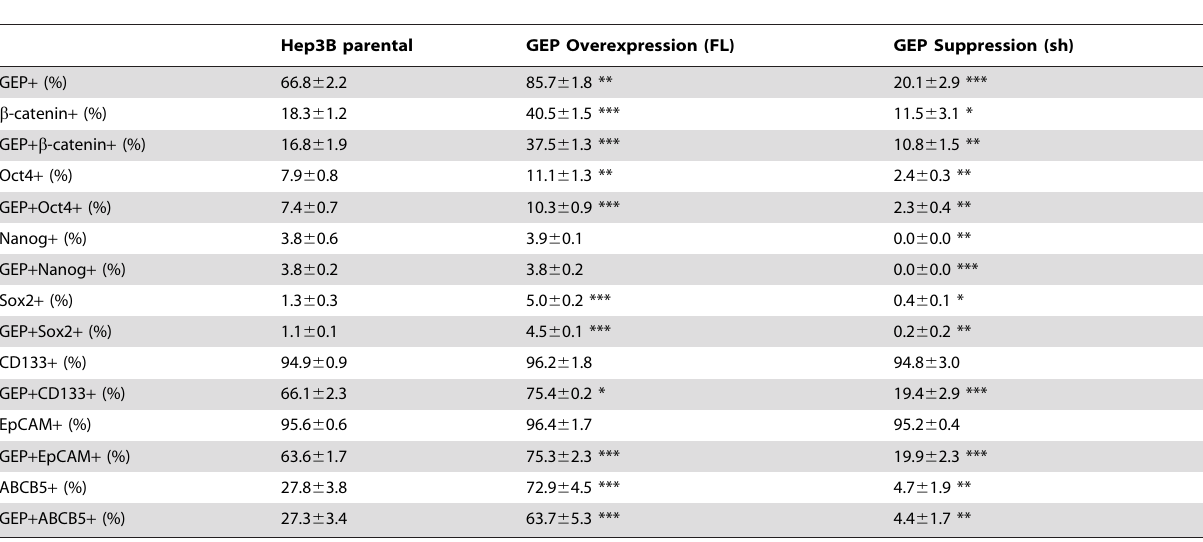
Table 1. GEP regulates stem cell marker expression in liver cancer cell line